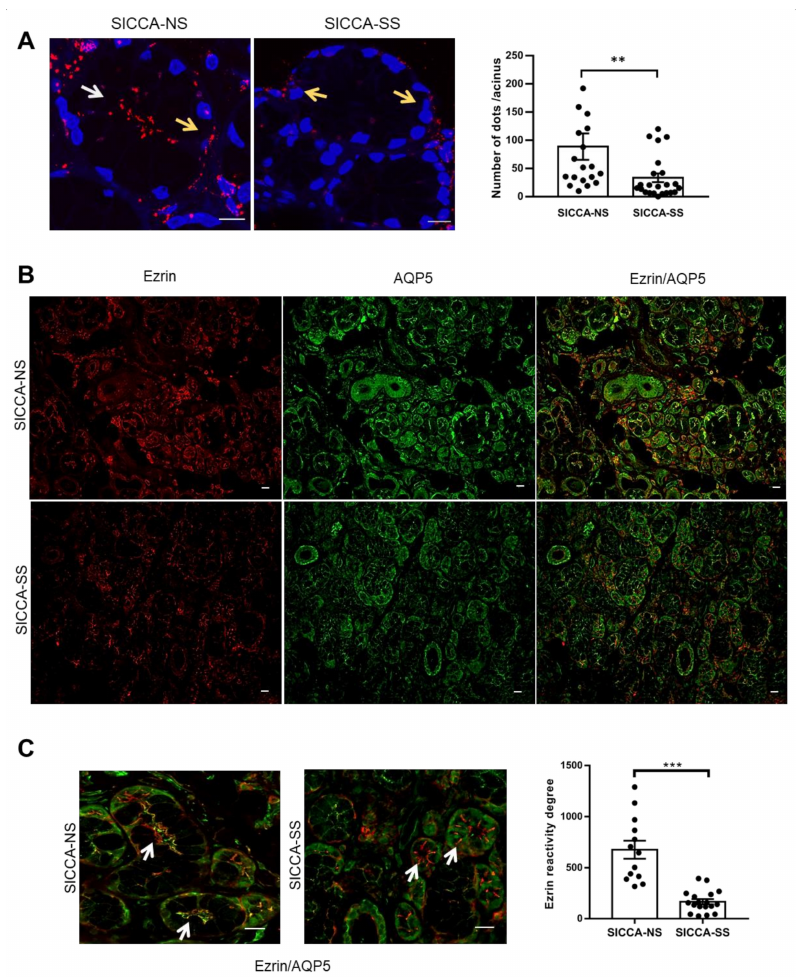
Figure 4. ( A ) Left, PLA on hMSG biopsies from SICCA-NS and SICCA-SS. Nuclei were labeled with DAPI (blue) and interactions are represented by red spots. White and yellow arrows indicate the apical and basal region, respectively. Scale bar, 10 µ m. Right, quantification of PLA red spots per acinus. Results are expressed as the mean ± S.E.M cells ( n = 19 SICCA-NS, 23 SICCA-SS). Statistical analysis was performed using the Mann–Whitney U test; ** p = 0.0017. ( B ) Representative immunoflu- orescence images of AQP5 (green) and ezrin (red) in SICCA-NS and SICCA-SS hMSG. Scale bar, 20 µ m. ( C ) Left, blow-up of the B panel squares showing merged channels (red—ezrin, green—AQP5, and yellow—ezrin/AQP5). Scale bar, 20 µ m. White arrows indicate the ezrin localization in the apical (SICCA-NS) and lateral (SICCA-SS) regions. Right, semiquantitative evaluation of ezrin expression. Results are expressed as the mean ± S.E.M. ( n = 13 SICCA-NS, n = 18 SICCA-SS). Statistical analysis was performed using the Mann–Whitney U test, *** p <